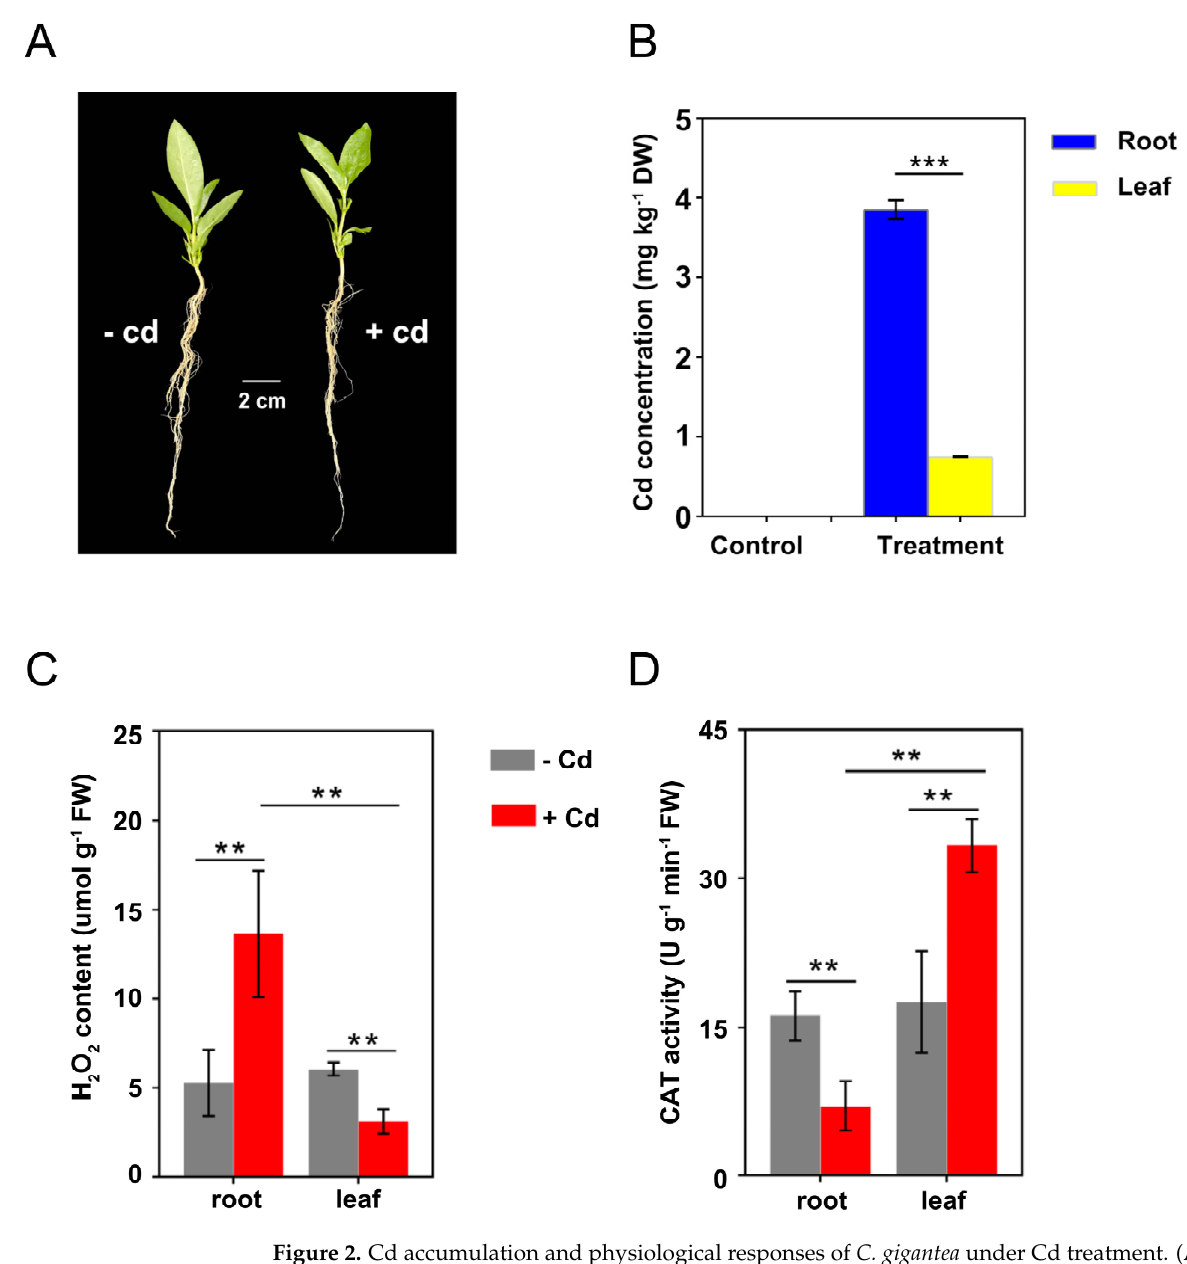
Figure 2. Cd accumulation and physiological responses of C. gigantea under Cd treatment. ( A ) Phe- notype of C. gigantea seedlings treated with and without 30 mg L –1 Cd (100 mL) for 24 h. ( B ) Cd concentrations in roots and leaves of C. gigantea . ( C ) H 2 O 2 concentrations in roots and leaves of C. gigantea . ( D ) CAT activities in roots and leaves of C. gigantea . One unit of CAT activity was defined as the quantity of enzyme degrading 1 µ mol H 2 O 2 per minute at 25 ◦ C per gram of tissue. Data represent the means ± standard deviations (n = 3); independent sample t test is performed between two pairs of samples; ** 0.001 < p < 0.01, *** p < 0.001 ( B – D ). FW: fresh weight. Under the control condition, there was no significant difference in H 2 O 2 concentration and CAT activity between the roots and leaves of C. gigantea . However, H 2 O 2 concentrations in roots increased from 3.12 to 13.63 µ mol g − 1 after Cd treatment, whereas those in leaves decreased from 6.07 to 3.12 µ mol g − 1 (Figure 2C). Under Cd treatment, CAT activities in roots decreased from 16.13 to 7.05 U g − 1 min − 1 , whereas those in leaves increased from 17.52 to 33.32 U g − 1 min − 1 (Figure 2D). Overall, the H 2 O 2 content and CAT activity in both roots and leaves were significantly altered by Cd treatment, but the direction of change